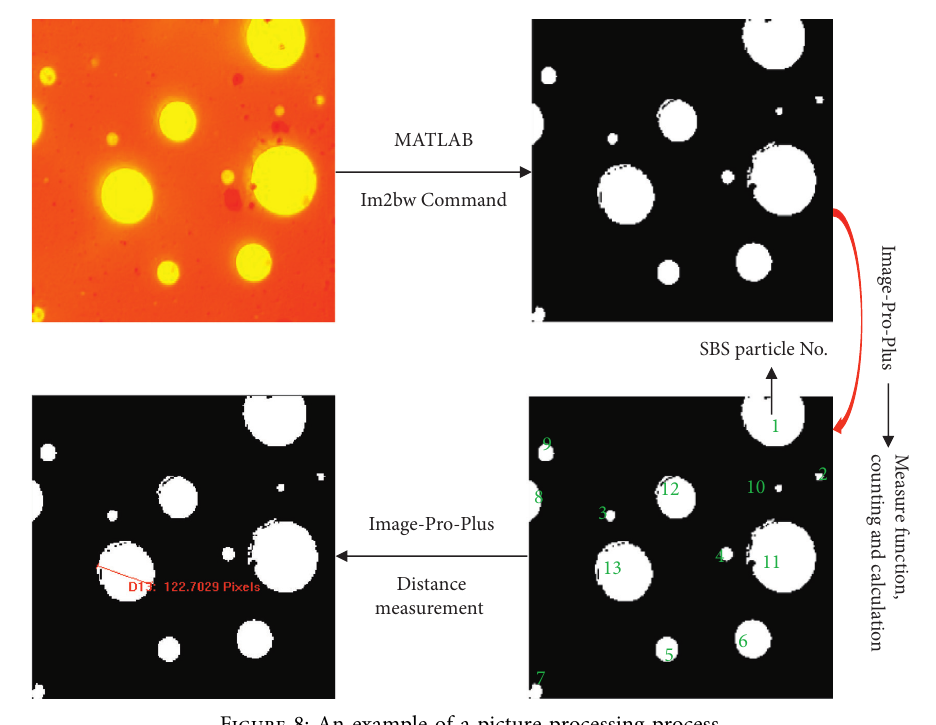
Figure 8: An example of a picture processing process.